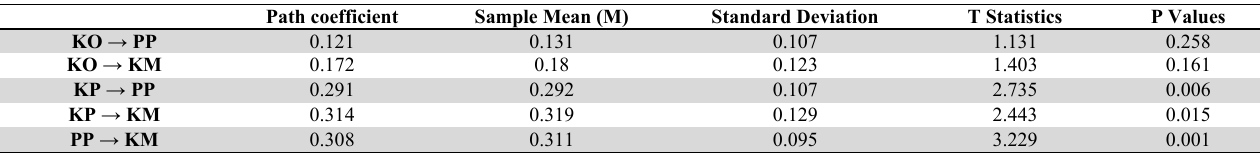
T-Statistics Test Results